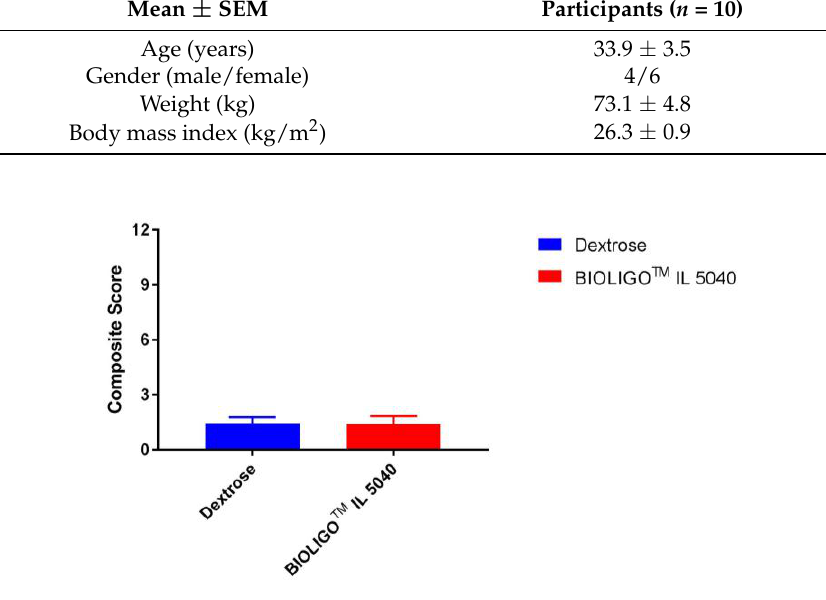
Figure 1. Composite gastrointestinal tolerance scores (Study 1). Table 3. Frequency of scores ≥2 a on individual gastrointestinal (GI) symptoms (Study 1). GI